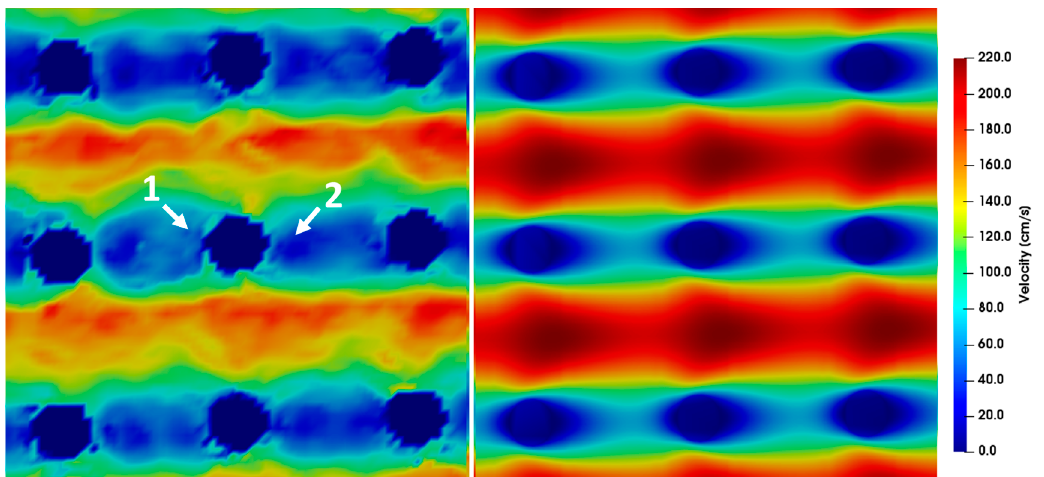
Figure 12. µPIV measurements ( left ) compared to simulations ( right ) showing the velocity field around posts at Re = 19.05. The direction of flow is from left to right and the pitch between the posts is 20 µm and the time difference between double frames is dt = 0.8 µs. For a better highlighting of the asymmetry, two arrows are inserted into the picture. The velocity before the post is higher (arrow 1) than the velocity after the post (arrow 2). Furthermore, the µPIV measurements do not attain the maximum velocities achieved by the simulations.